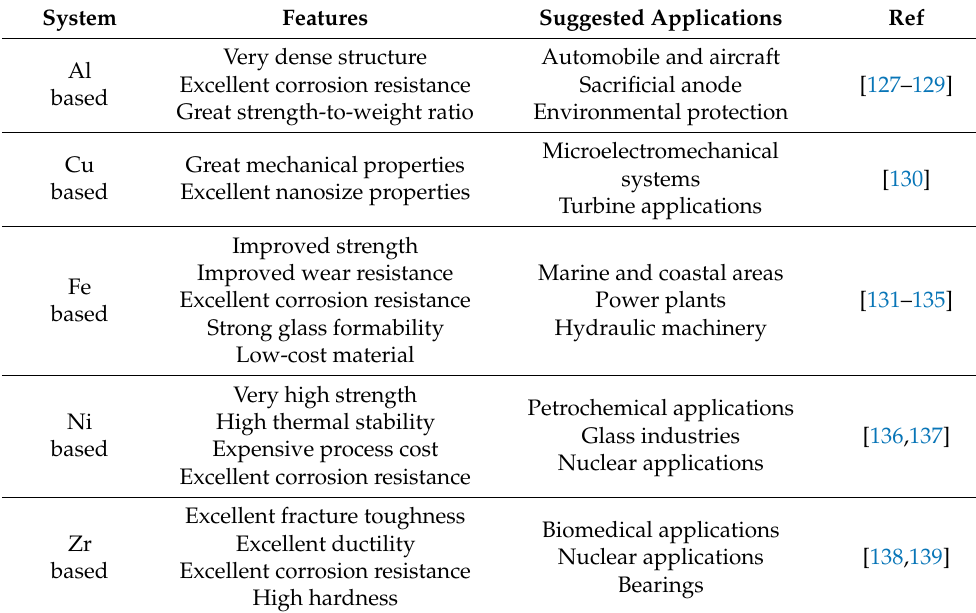
Table 6. Thermal spray coating of various types of metallic glasses. System